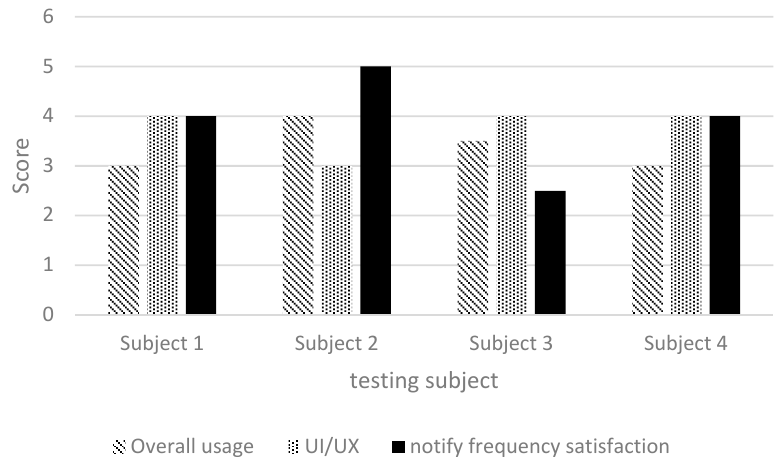
Figure 21. Questionnaire results.